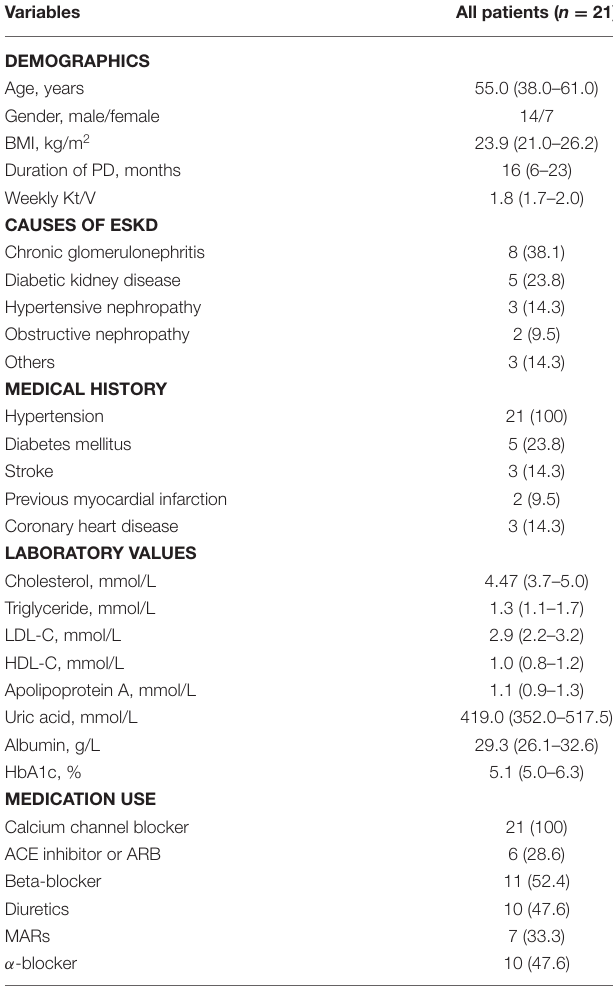
TABLE 1 | Baseline characteristics of PD patients initially presenting before sacubitril-valsartan